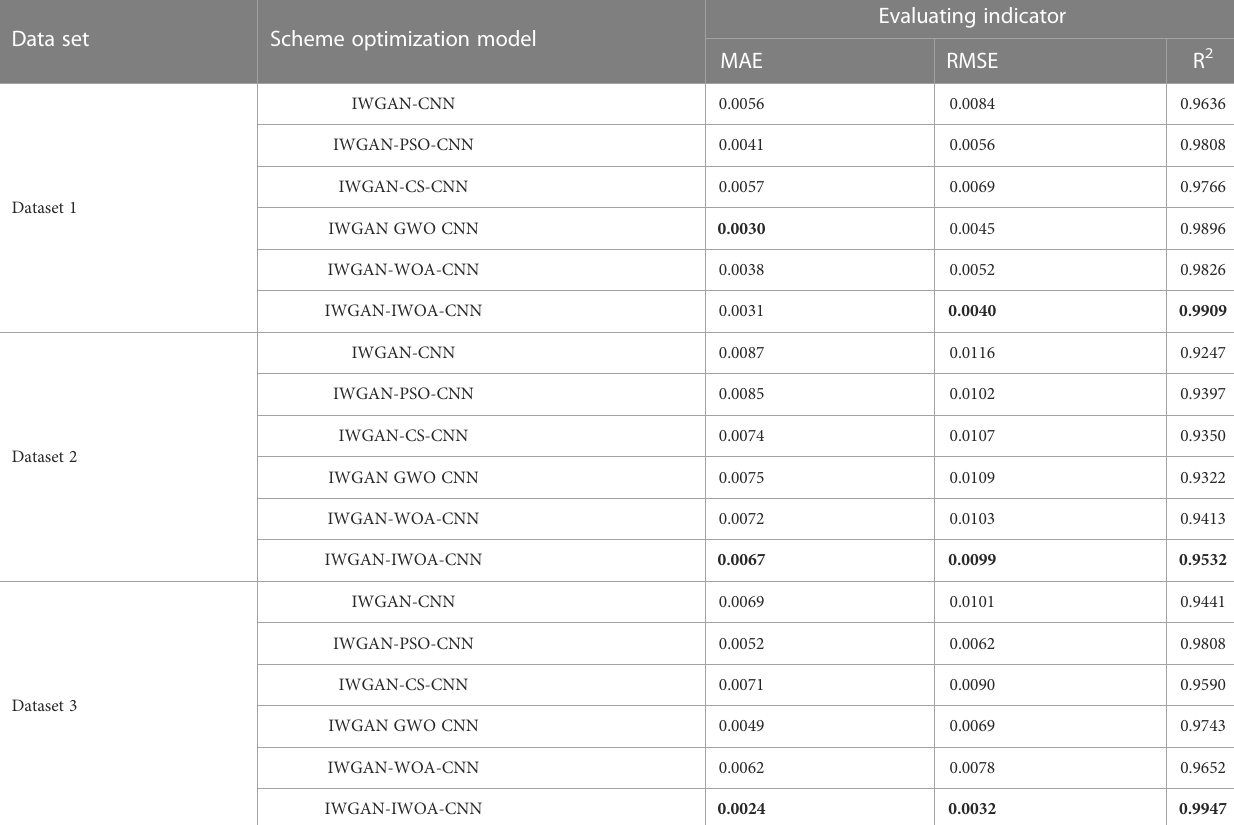
TABLE 4 Comparison of experimental results of models under different optimization algorithms.